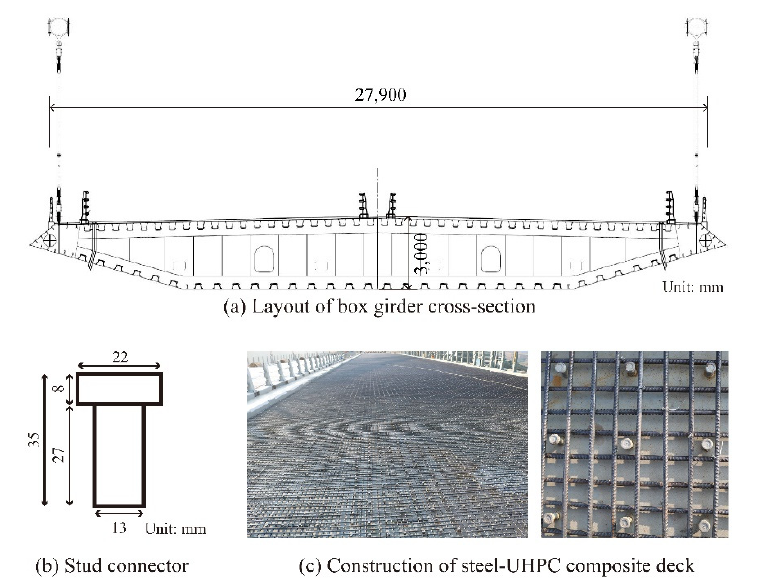
Figure 2. The layout of the girder cross-section, stud connector, and construction of the composite deck.